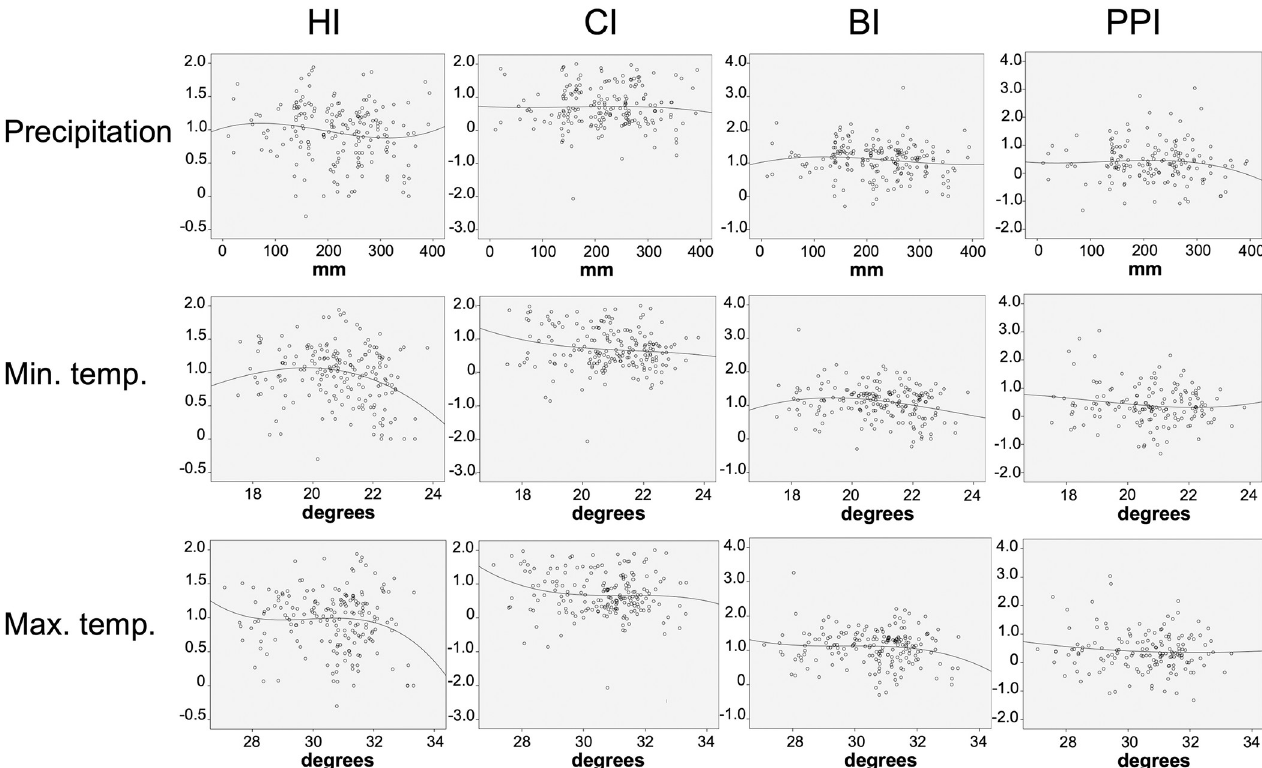
Fig 6. Relationship between vector density indices and climate variables, 2013–2018. Monthly values for each Aedes vector index: House Index (HI), Container Index (CI), Breteau Index (BI) and Pupal Productivity Index (PPI) were correlated with monthly precipitation, monthly minimum temperature (min. temp.) and monthly maximum temperature (max. temp.) across the 65